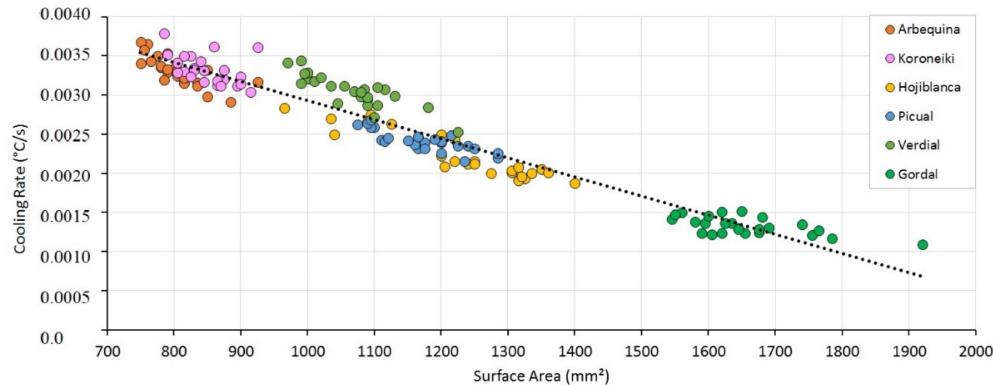
Figure 5. Correlation between surface area (mm) and cooling rate ( ◦ C/s) of different olive cultivars ( n = 150).